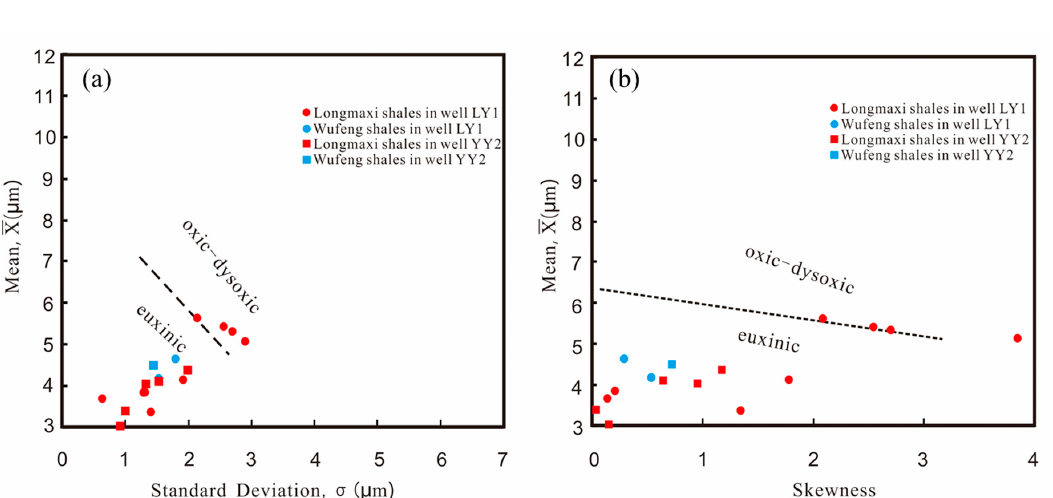
Figure 6. ( a ) Plot of the mean versus the standard deviation of the framboid size distribution of three wells. The dashed lines at the euxinic boundary and the oxic-dysoxic boundary are from Wei et al. (2016); ( b ) plot of the mean versus the skewness of the framboid size distribution of three wells. The dashed line is from Wei et al. (2016).